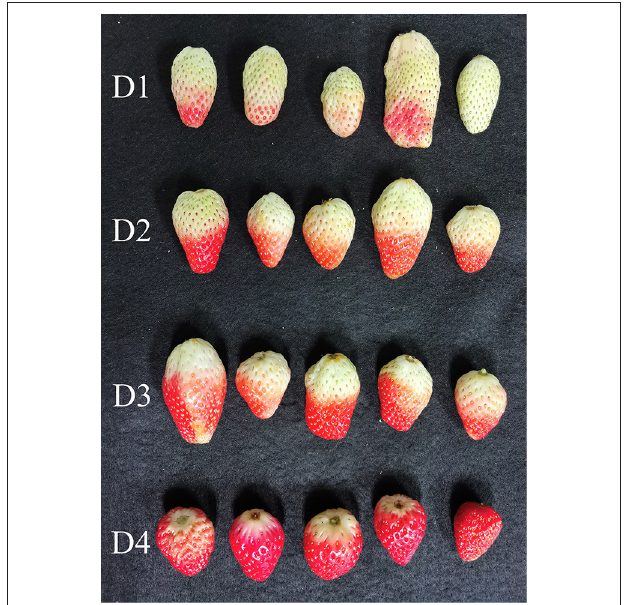
FIGURE 1 | Images of strawberries of the four maturity degree (D1: the portion of the red color areas below 25%; D2: the portion of the red color areas between 26 and 50%; D3: the portion of the red color areas between 51 and 75%; D4: the portion of the red color areas between 75 and 100%).